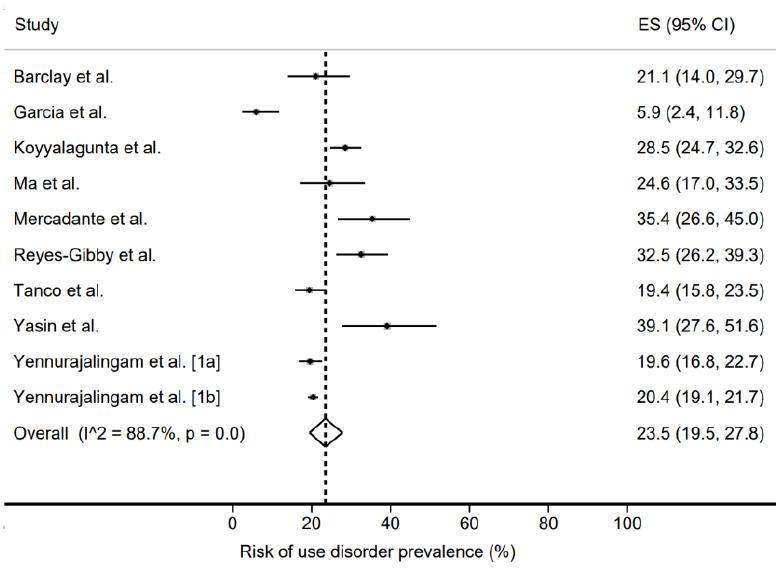
Figure 3. Risk of use disorder prevalence [19,22–30].